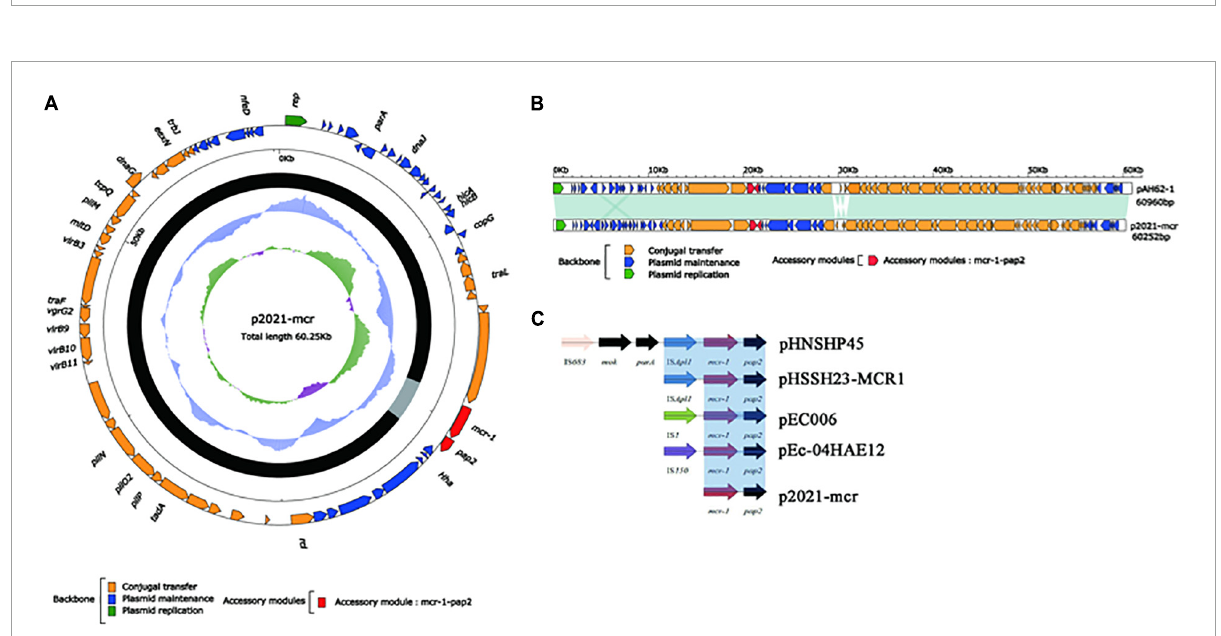
FIGURE9 The complete sequence circular diagram of p2021- mcr . (A) The innermost ring represents (G-C)/(G + C); the blue ring indicates GC content, and the outward depression indicates that the GC content is higher than the mean value. Black area in the outer circle represents the backbone area and gray area represents the accessory modules. The outermost circle shows the distribution of genes represented by colored arrows in the plasmid. (B) Linear comparison of p2021- mcr and pAH62-1. Shadows indicate nucleotide homology is greater than 95%. (C) The diversity of mcr-1 upstream environment of rci in Inc2